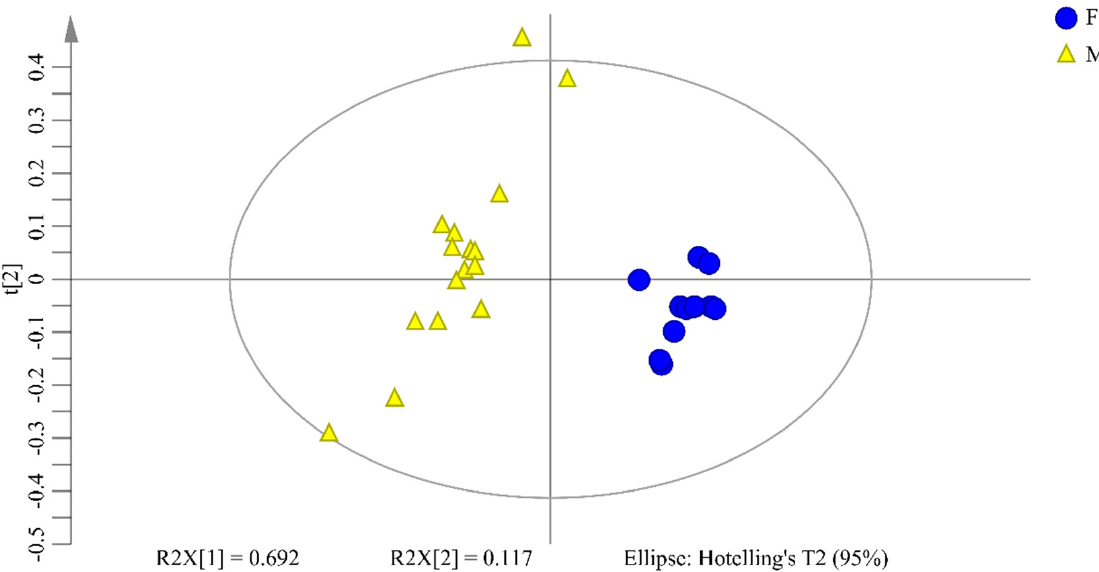
Figure 4. PCA scores plot for female and male flower buds of P. tomentosa . Circles represent female samples and triangles represent male samples. The X axis refers to the score of the first principal component (PC1) and the Y axis refers to the score of the second principal component (PC2). The variances accounted by PC1 and PC2 are 69.2% and 11.7%, respec- tively.